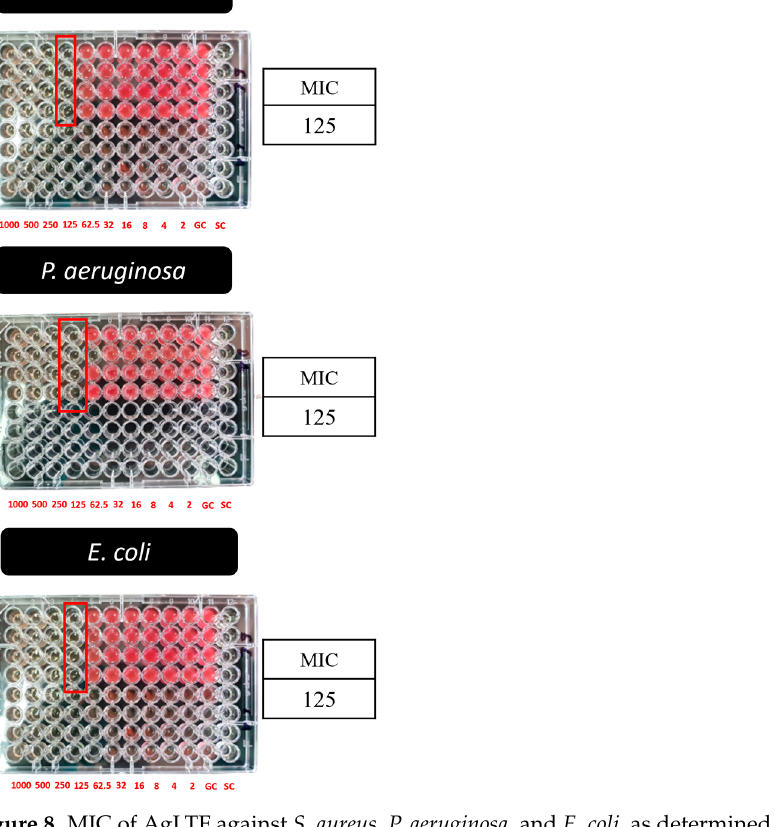
Figure 8. MIC of AgLTF against S. aureus , P. aeruginosa, and E. coli, as determined by the microbroth dilution assay, n = 4. Table 4. Zone of inhibition for S. aureus , P. aeruginosa, and E. coli for the AgLTF, SL, and DL gels, n =